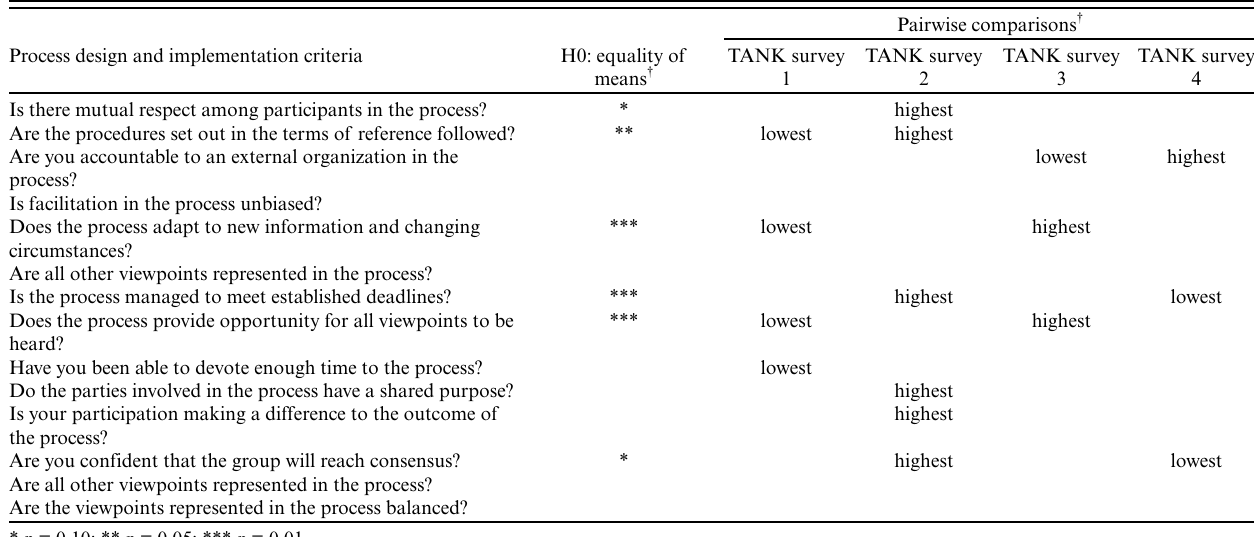
Table 7 . TANK (T ū taekur ī , Ahuriri, Ngaruroro, and Karam ū ) equality of means over time.